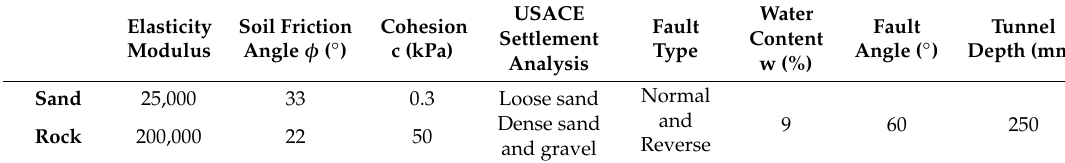
Table 8. Soil properties used in PLAXIS.